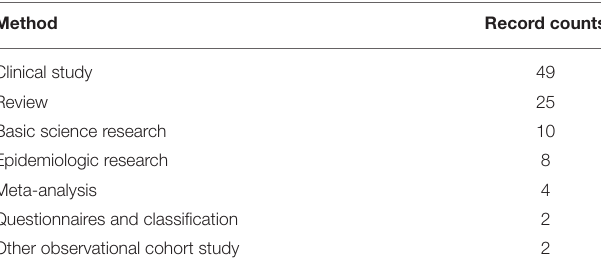
TABLE 6 | Research methods.